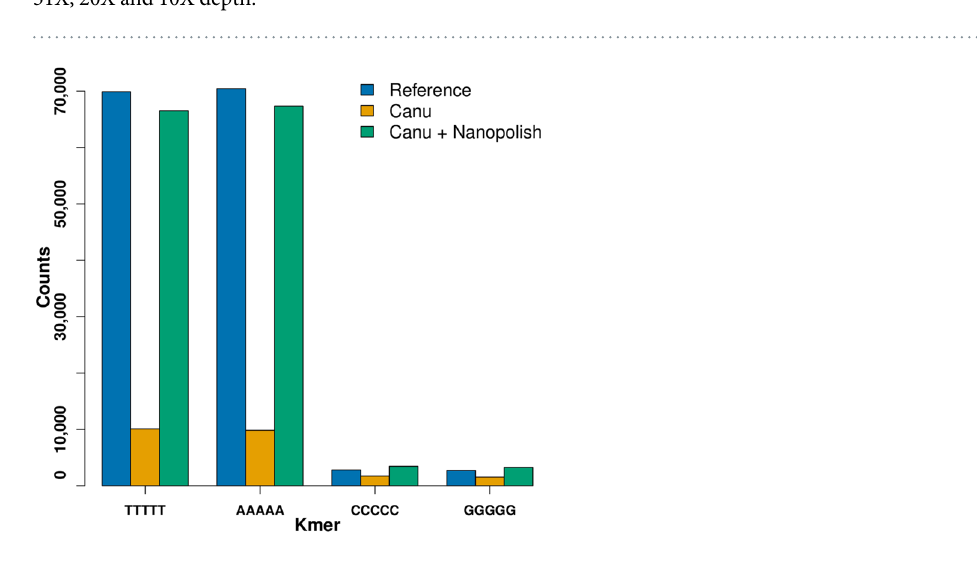
Figure 2. Homomer counts. Counts for the 5 bases homomers in the Reference (blue), in the Canu assembly (orange), and in the Canu assembly after polishing with Nanopolish